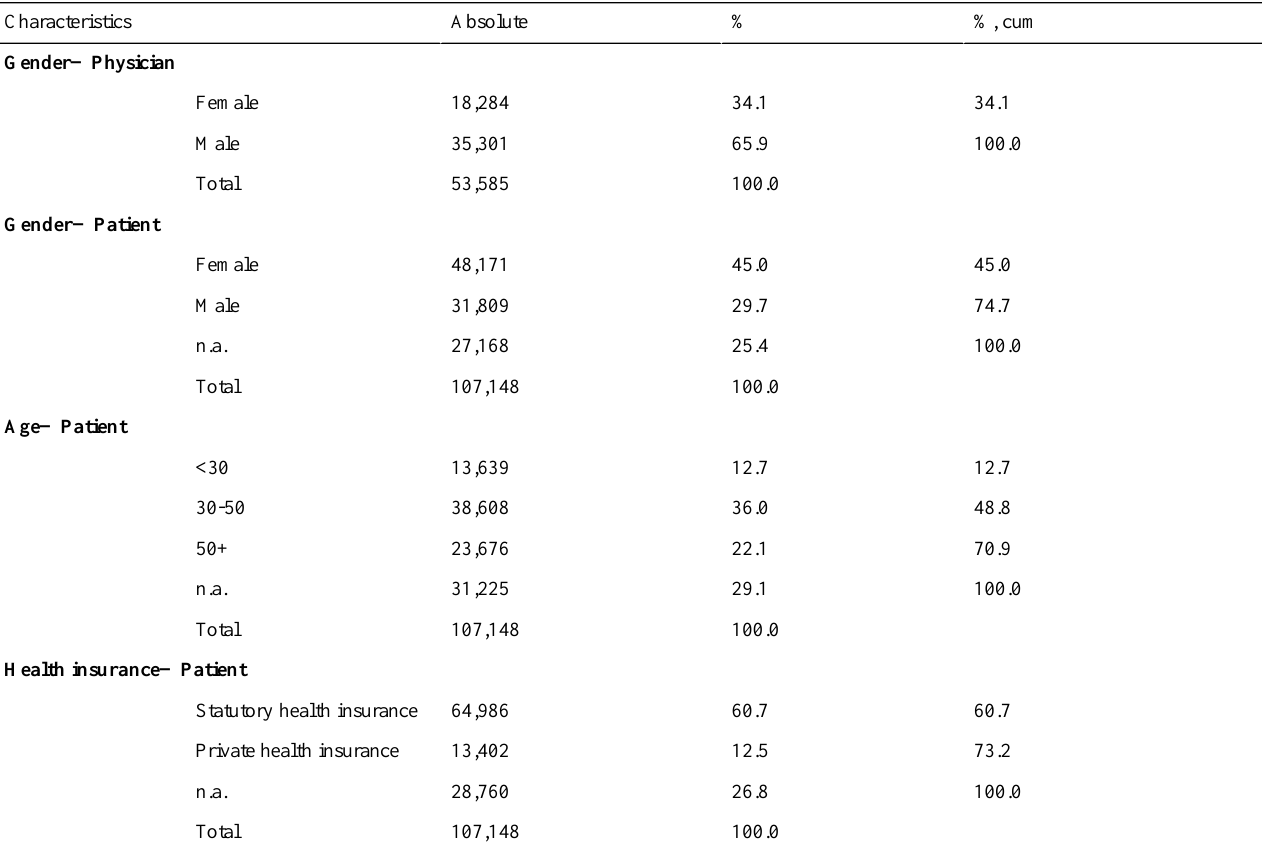
Table 1. Number and distribution of ratings on jameda (gender, age, insurance).